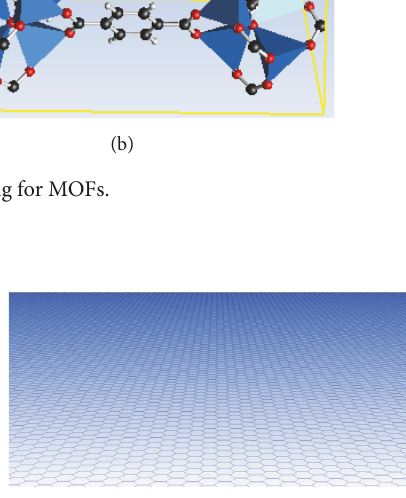
Figure 9: Macromolecular material